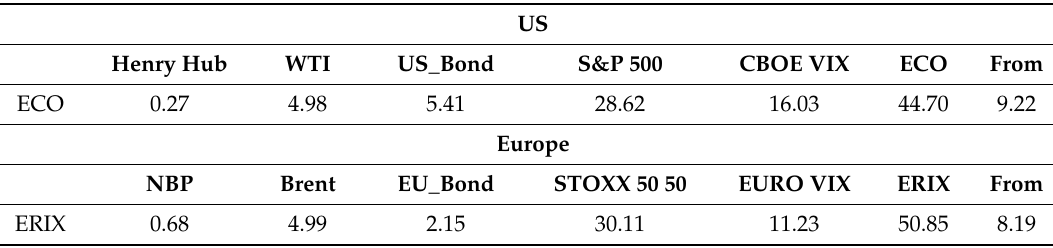
Table 4. Return spillover